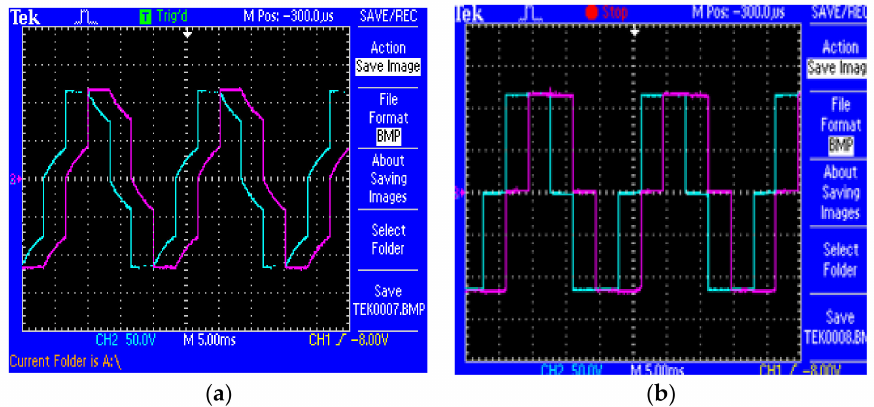
Figure 18. Inverter outputs at various load